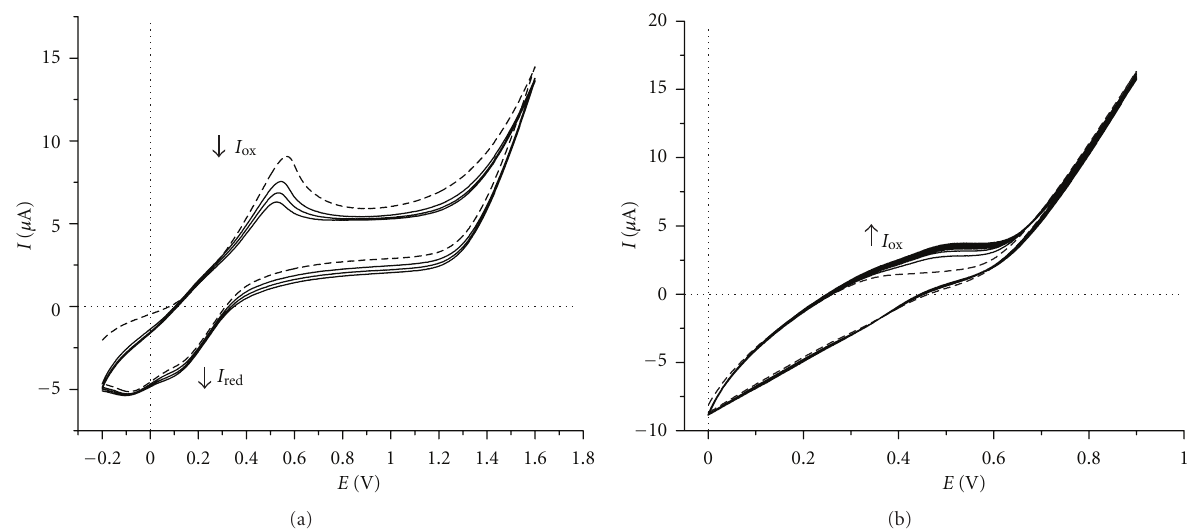
Figure 2: Multicyclic voltammograms of (a) 1.0 mM DAnPS (water dispersion) and (b) 1.0mM AnPS on Pt electrode (disk-shaped, 1.6 mm diameter) recorded in bidistillated water; the dotted line represents the first cycle. Scan rate: 50 mVs − 1 .